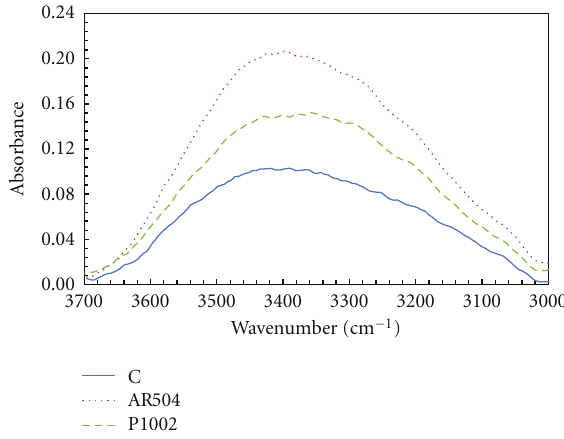
Figure 6: Infrared absorbance of sunflower hull/PP blends contain- ing no compatibilizer, maleated AR504 compatibilizer, and acry- lated P1002 compatibilizer. Absorbance in 3000 cm − 1 to 3700 cm − 1 range is indicative of the hydroxyl functional group.